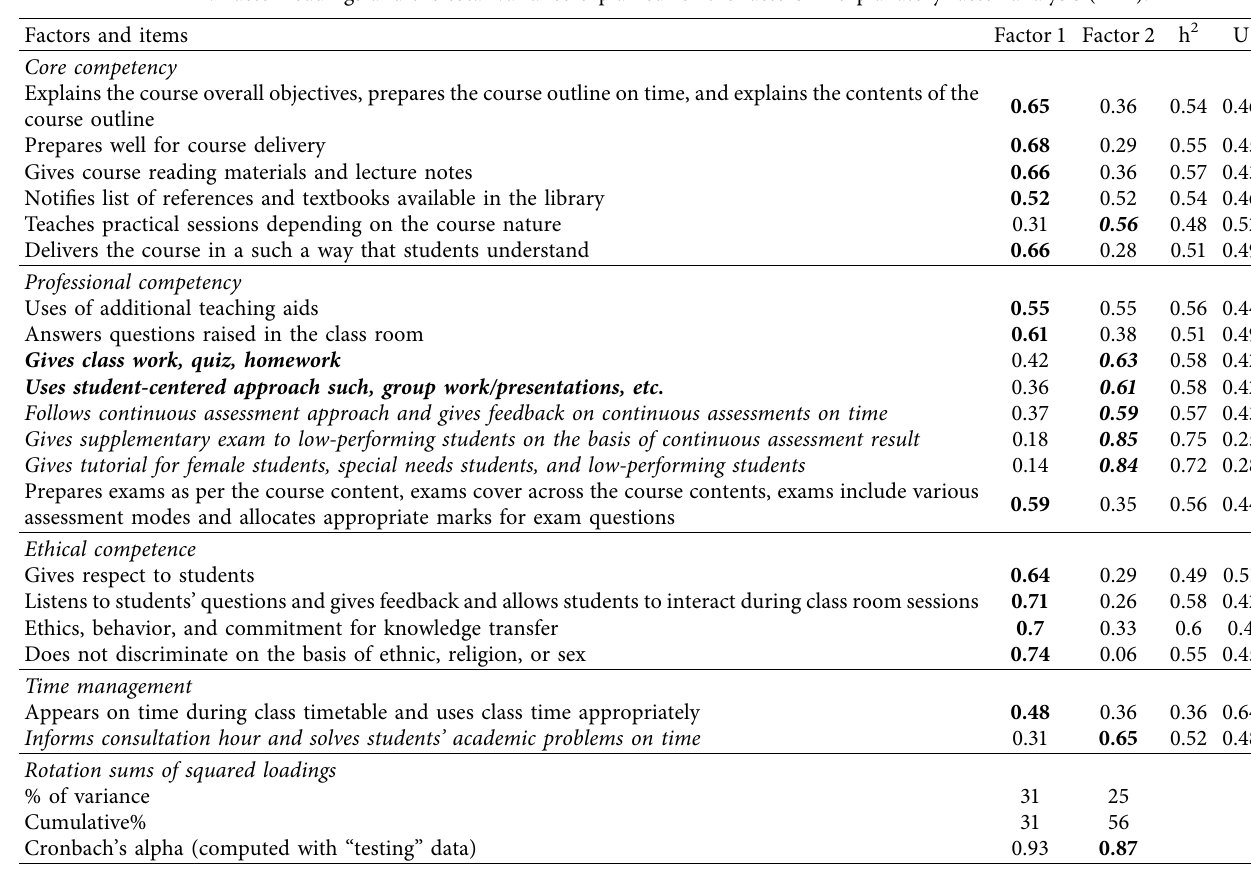
Table 4: Factor loadings and the total variance explained for the factors in explanatory factor analysis